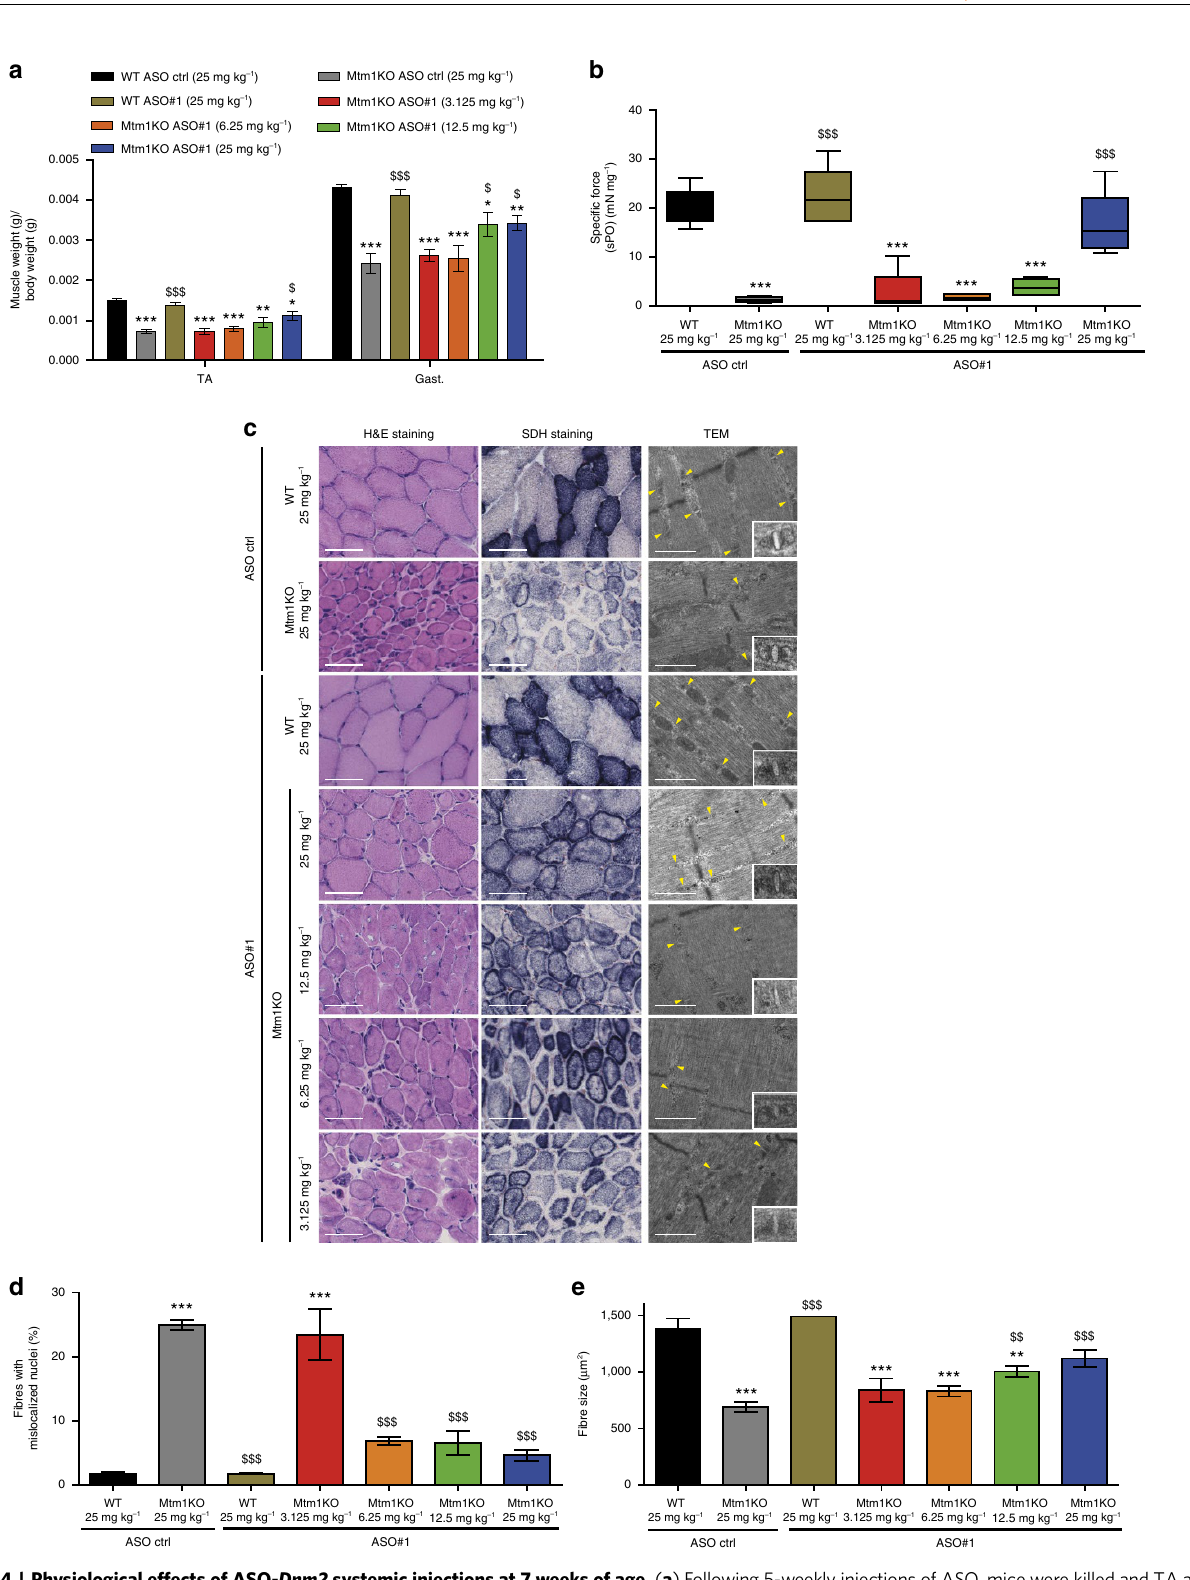
Figure 4 | Physiological effects of ASO- Dnm2 systemic injections at 7 weeks of age. ( a ) Following 5-weekly injections of ASO, mice were killed and TA and gast. muscles were weighed ( n ¼ 5–7 mice per group). ( b ) TA specific muscle force was measured after sciatic nerve stimulation. The specific muscle force was calculated by dividing the absolute force by the TAweight ( n ¼ 5–7 mice per group). ( c ) TA muscle sections were stained for H&E or SDH. Sarcomere and triads (yellow arrows) ultrastructure was assessed by TEM. Scale bars: 50 m m (H&E and SDH) or 500nm (TEM) images. ( d ) Percentage of fibres with mislocalized nuclei was determined in 1,000 fibres ( n ¼ 5–6 mice per group). ( e ) TA muscle fibre area was calculated on 300–600 fibres per sample ( n ¼ 5 mice per group). Data represent mean ± s.e.m. * P o 0.05, ** P o 0.01, *** P o 0.001 for mice treated with ASO Dnm 2 versus WT treated with ASO ctrl. $ P o 0.05, $$ P o 0.01, $$$ P o 0.001 for mice treated with ASO Dnm 2 versus Mtm1KO treated with ASO ctrl (two-way ANOVA followed by post hoc